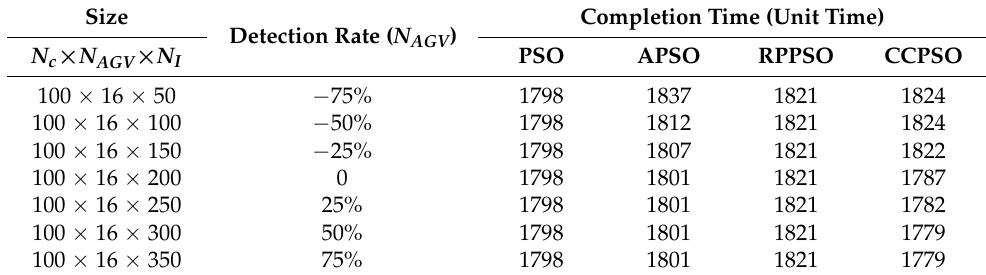
Table 8. Sensitivity test data of iteration